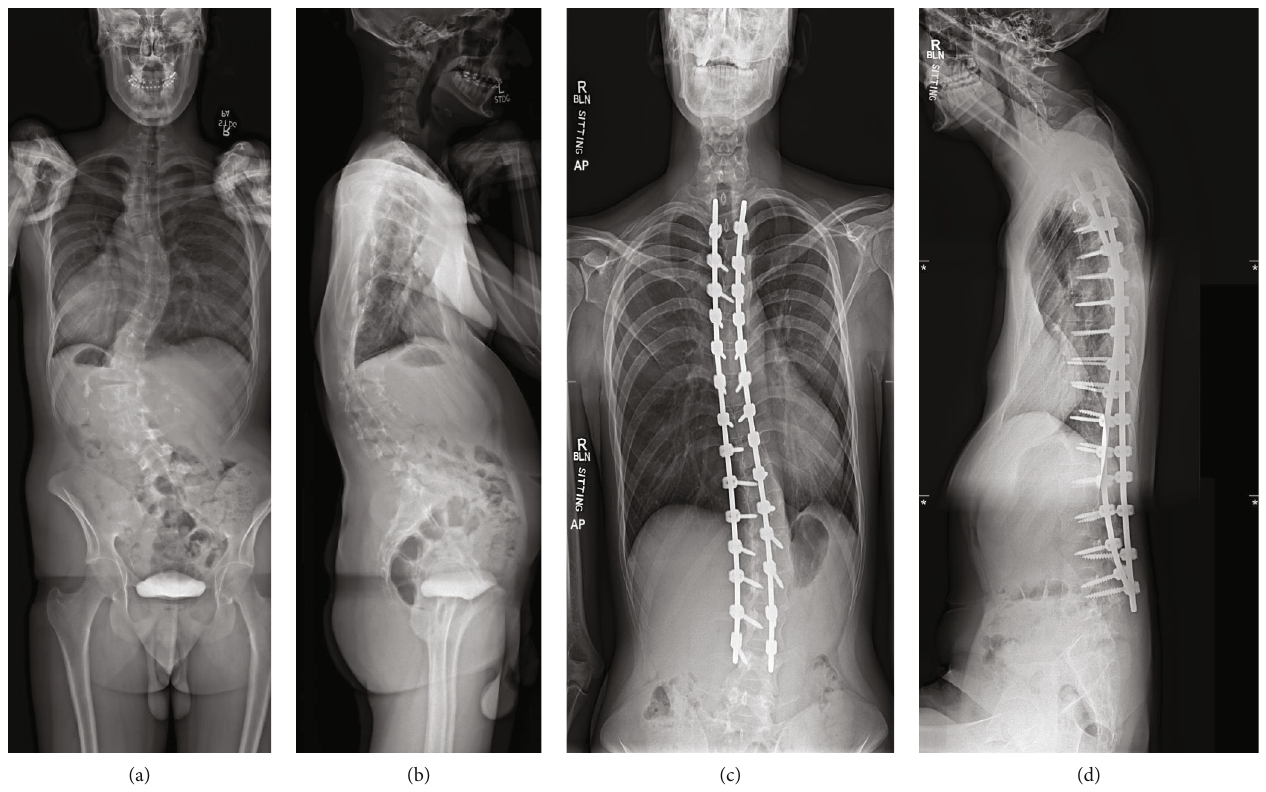
Figure 3: Preoperative and postoperative radiographs. The top two images are the preoperative standing posterior-anterior (a) and lateral (b) plain radiographs of the entire spine. The bottom two images are six-month postoperative standing anterior-posterior (c) and lateral (d) plain radiographs of the